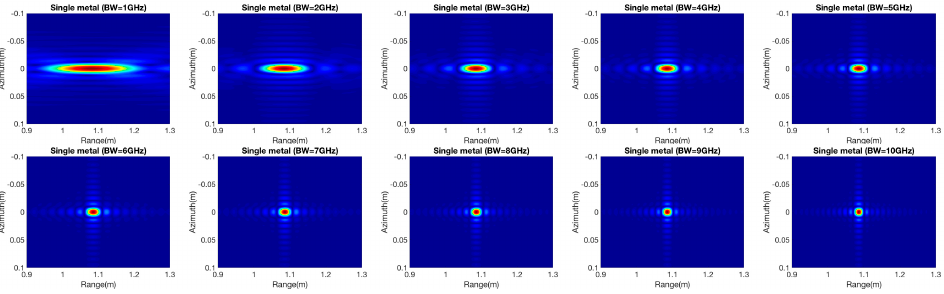
Figure 10. Image of a metal sphere with SAR bandwidth varying from 1 GHz to 10 GHz.